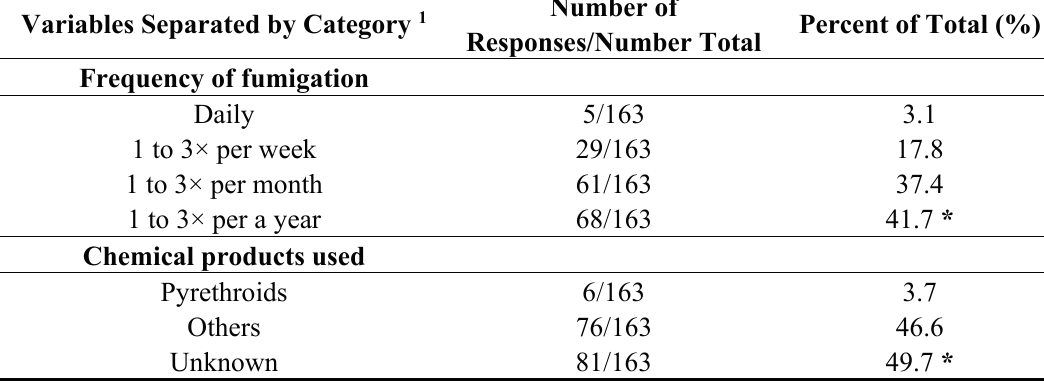
Table 3. Information on home fumigation from respondents who live in areas near the Mossoró River, in the neighborhoods of Ilha de Santa Luzia, Alto da Conceição and Paredões, in the city of Mossoró, Rio Grande do Norte,